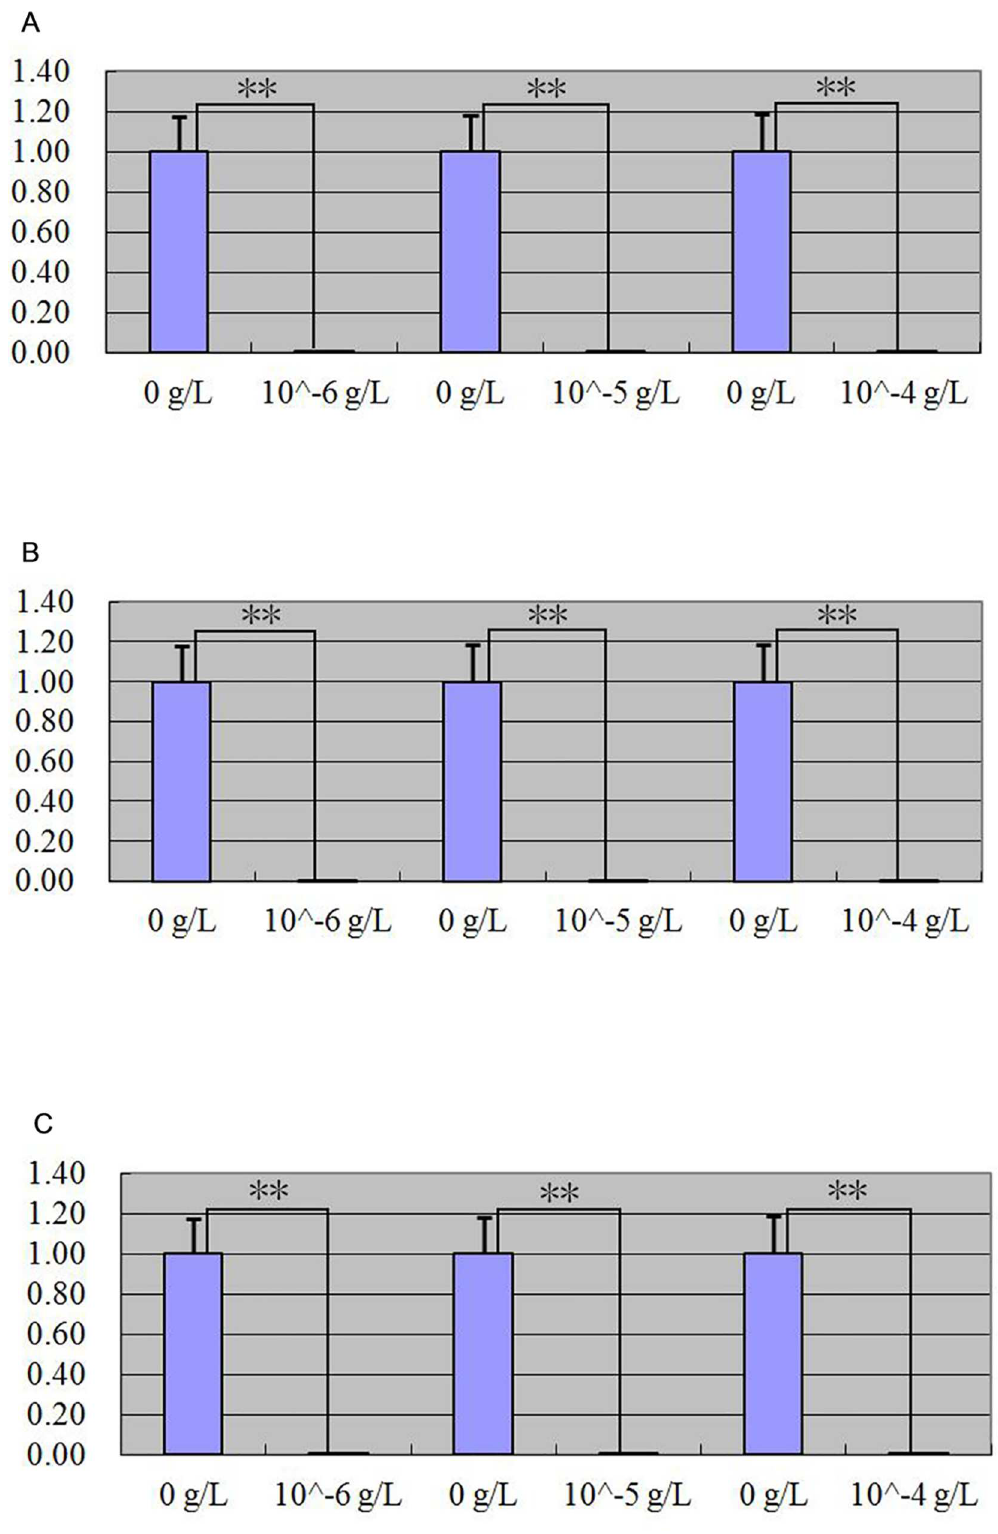
Fig 10. Expression quantity change of keratin 26 after IGF-I treatment was detected by quantitative real- time PCR. Fig 10A. Expression quantity of keratin 26 was 0.00011595 × (p < 0.01), 0.0000083 × (p <